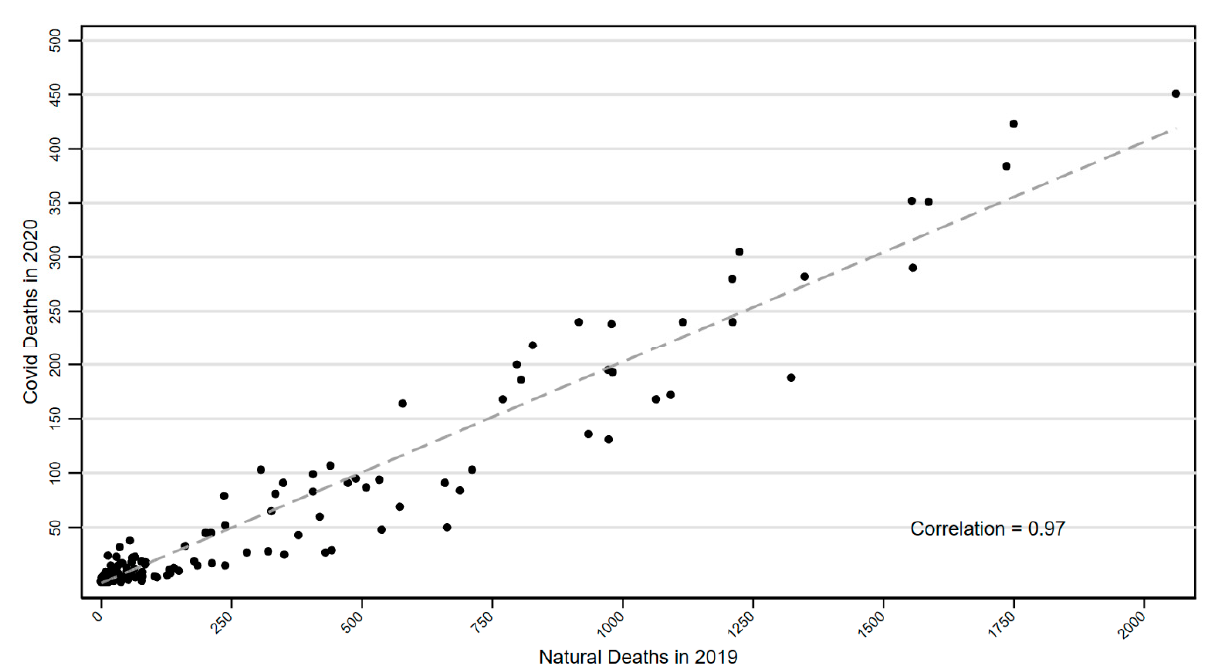
Figure 1. Out-of-Sample Correlation for Indiana between Natural Mortality in 2019 and COVID-19 Mortality in 2020. Figure shows scatterplot of natural mortality in Indiana over April–December 2019 against COVID-19 mortality over April–December 2020, for groups defined by age (18–39, 40–49, 50–59, 60–69, 70–79, 80–89, 90+), gender, race/ethnicity, and zip-SES quintile. This figure also shows a best-fit regression line and a Pearson correlation coefficient. See Figure S2 for similar in-sample scatterplots for Wisconsin and Milwaukee County.